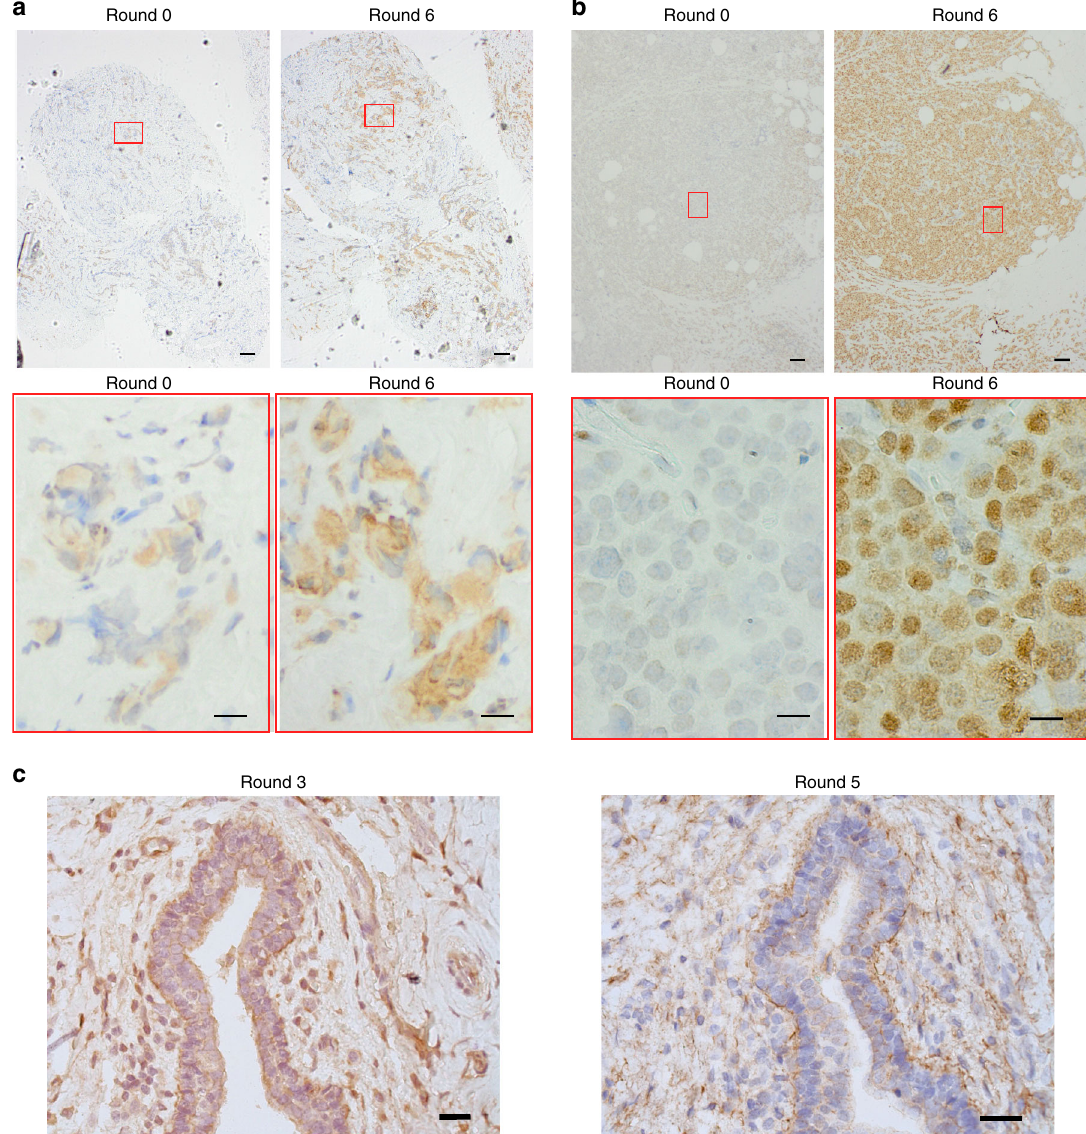
Fig. 3 Enriched ssDNA library validation. a Staining of the tissue from the NB case that was used during the selection process with unenriched library (round 0), compared to the enriched EL-NB library (round 6; upper panel: ×4, 100 µ m scale bar, lower panel: ×60, 14 µ m scale bar); b Staining of tissue from an NB case not used during the selection process with unenriched library (round 0), compared to the enriched library EL-NB (round 6; upper panel: ×4, 100 µ m scale bar, lower panel: ×60, 14 µ m scale bar); c Staining of the tissue from the bene fi ter case employed for counter selection in the enrichment of EL-NB, using the output ssDNAs from round 3 (left, ×20, 40 µ m scale bar), compared to the output ssDNAs from round 5 (right, ×20, 40 µ m scale bar). No adjustment was applied to images from